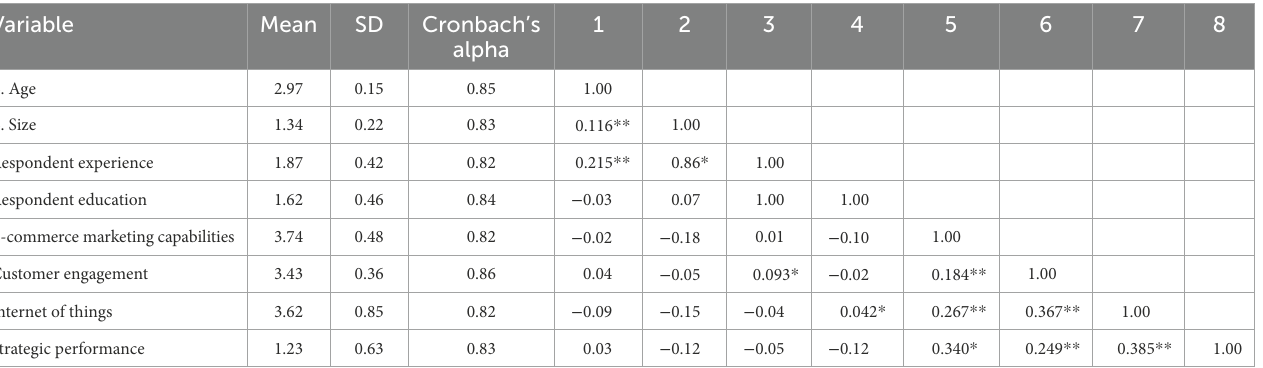
TABLE 3 Mean, SD, and correlation matrix.